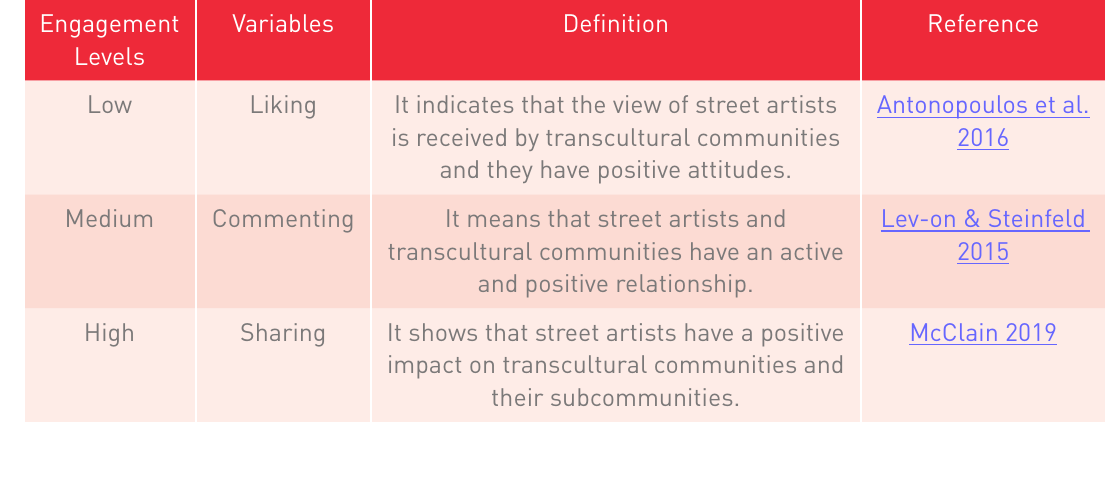
Table 1. Coding variables and